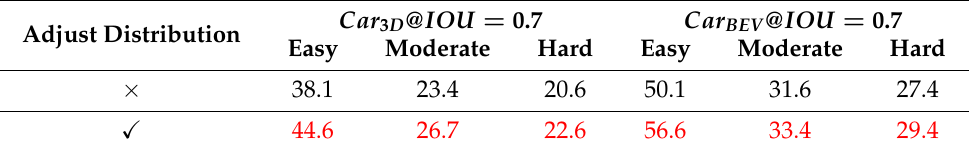
Table 9. Ablation study on depth distribution adjustment with the “car” category of the KITTI validation subset.